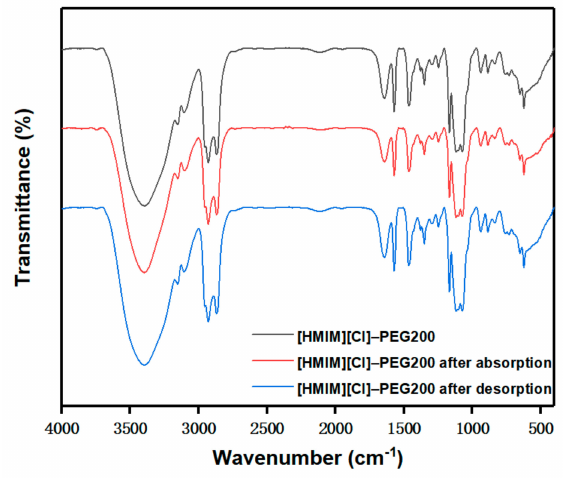
Figure 7. IR spectra of [HMIM][Cl]–PEG200, [HMIM][Cl]–PEG200 after absorption, and [HMIM][Cl]– PEG200 after desorption.